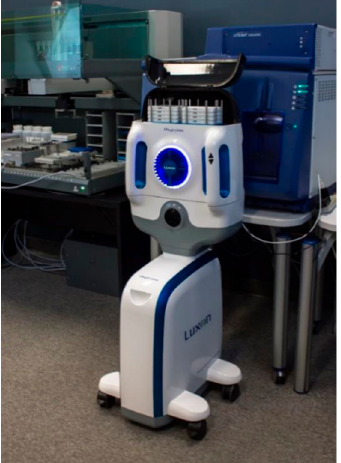
Figure 3. Laser diode thermal desorption ion source tandem mass spectrometry ( LDTD-MS/MS) analysis (Source: [61] ).